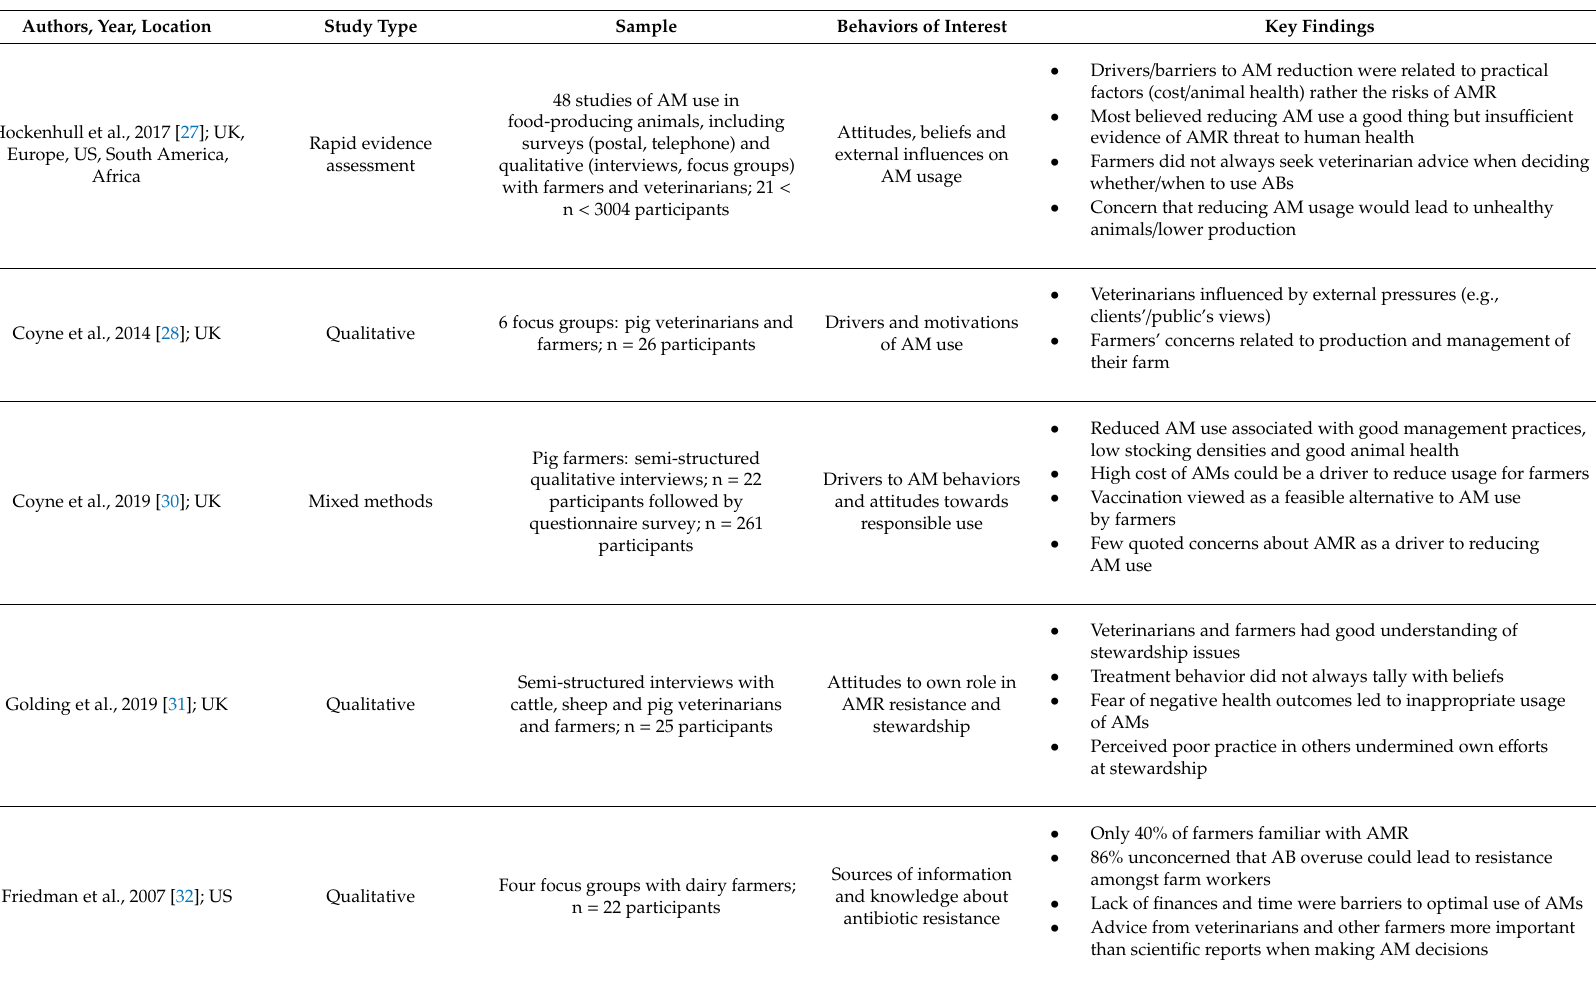
Table 2. Reviewed studies of psychological determinants of antibiotic (AB) / antimicrobial (AM) usage and AB / AM resistance (ABR) / (AMR) in farmed animals. Authors, Year,